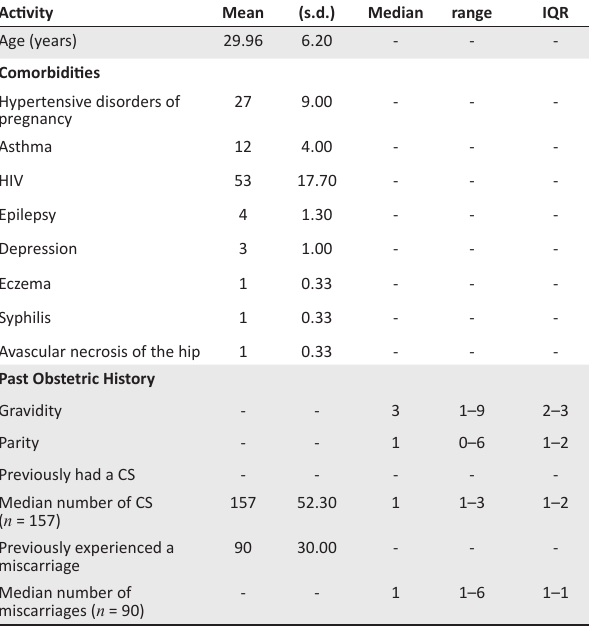
TABLE 1: Sociodemographic and health profile of patients ( n = 300).